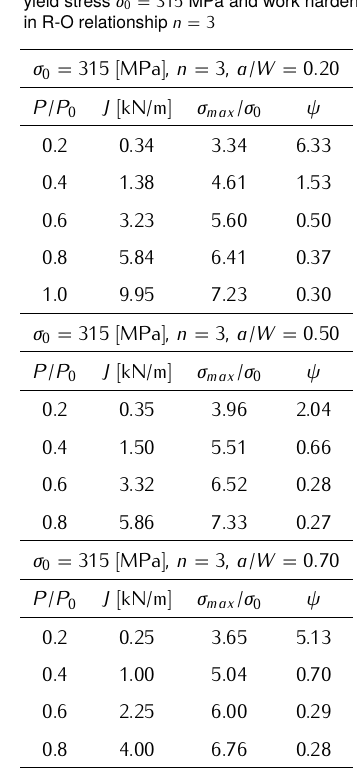
Table A1. Numerical results for CC(T) specimens characterized by yield stress σ MPa and work hardening exponent 0 = 315 in R-O relationship n = 3